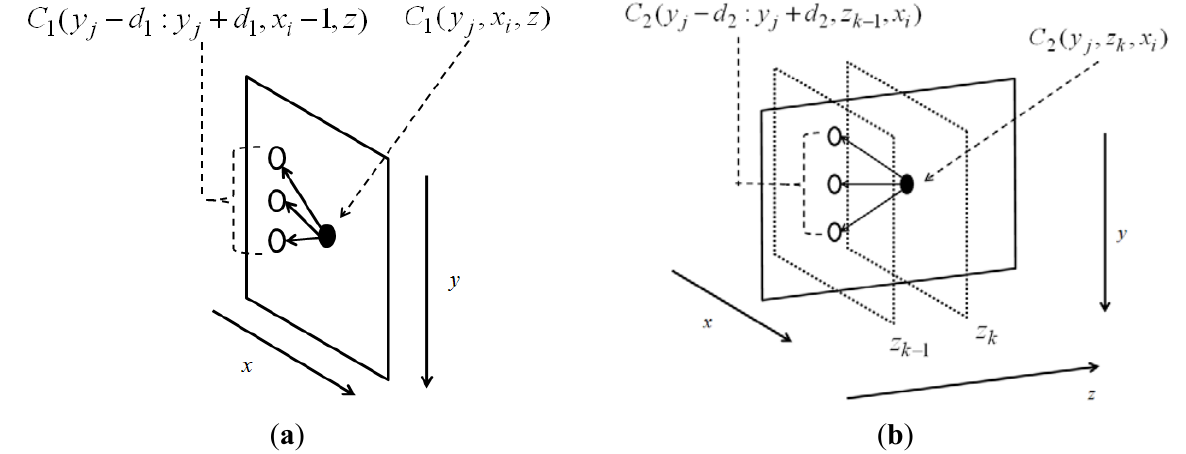
Figure 2. The accumulation matrices C same as those of